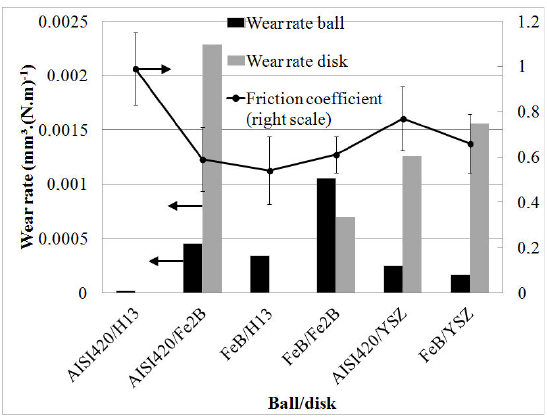
Figure 5. Wear rates and friction coefficients for the studied friction couples. Bars indicate dispersion of friction coefficient during the test rather than confidence intervals. No wear rate could be calculated for H13 disks because the mass variation is very low. Arrows indicate to which scale the graph refers to.